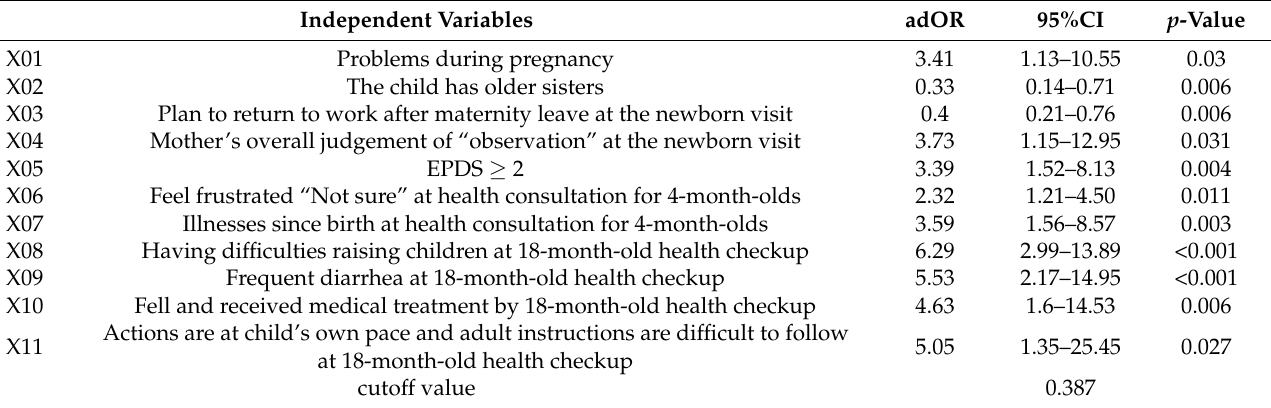
Table 2. Adjusted odds ratios (adORs) from the logistic regression model. Independent Variables